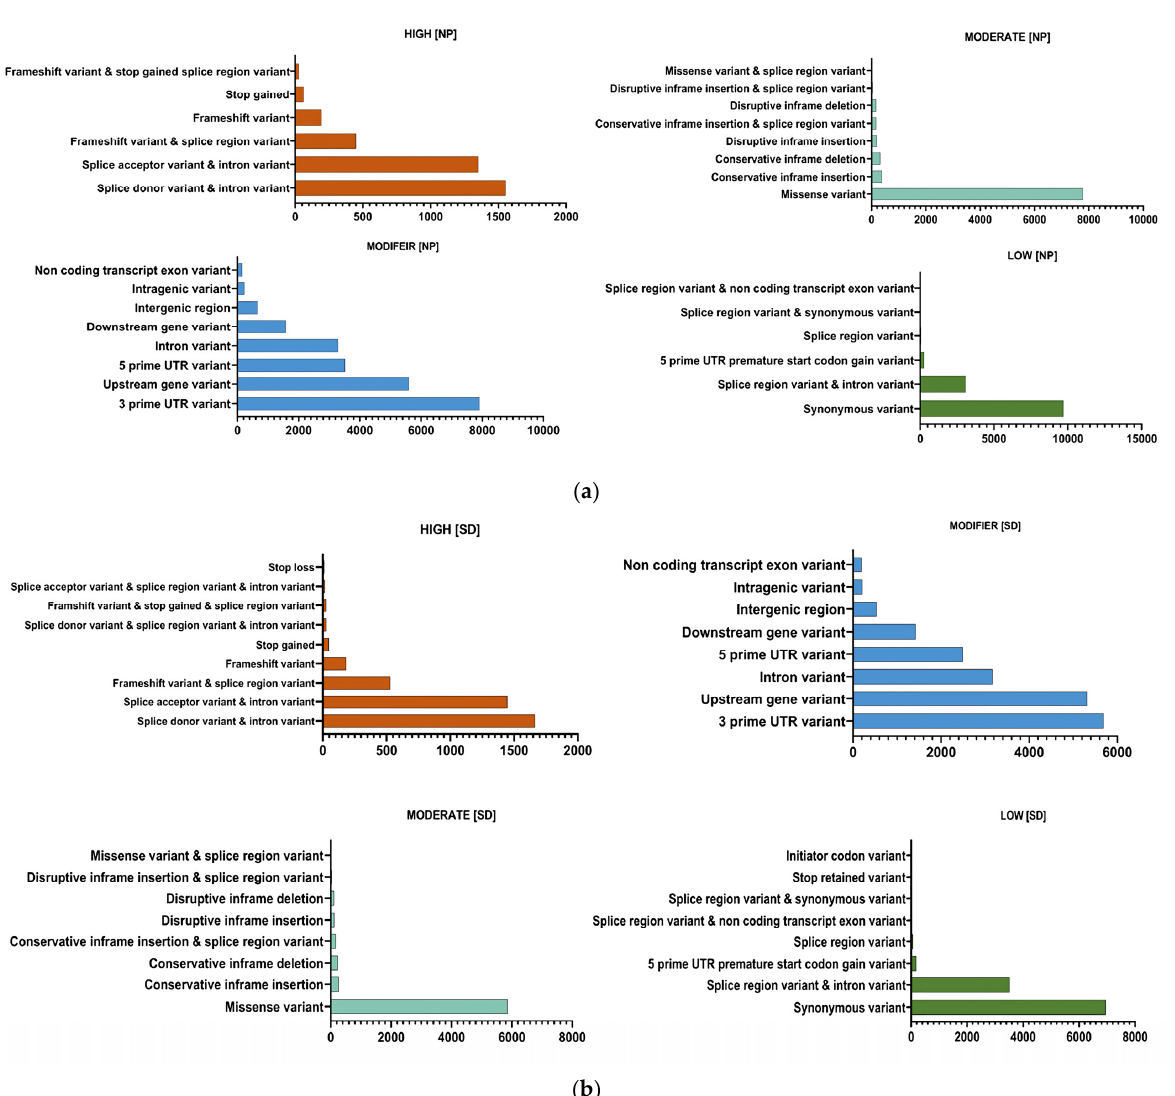
Figure 8. Distribution of the subcategories of the variants classified by impact. The y -axis represents the subcategories of the variants, and the x -axis represents the number of the variants corresponding to the subcategories: ( a ) Nampungchal variants in the high, moderate, modifier, and low category; ( b ) Sodamchal variants in the high, moderate, modifier, and low category. NP, Nampungchal; SD, Sodamchal.